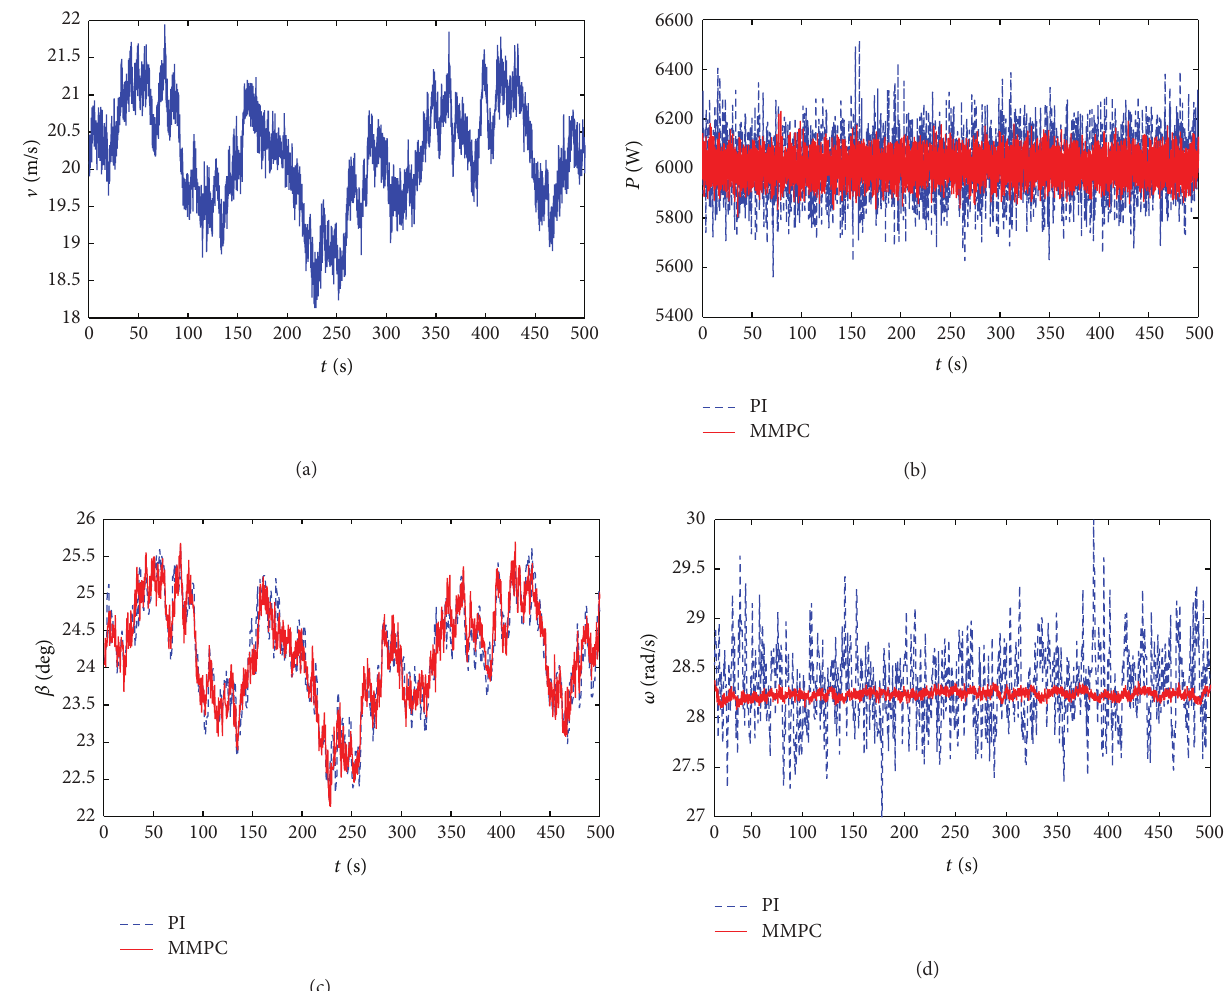
Figure 9: (a) Wind speed. (b) Generator power. (c) Pitch angle. (d) Turbine rotational